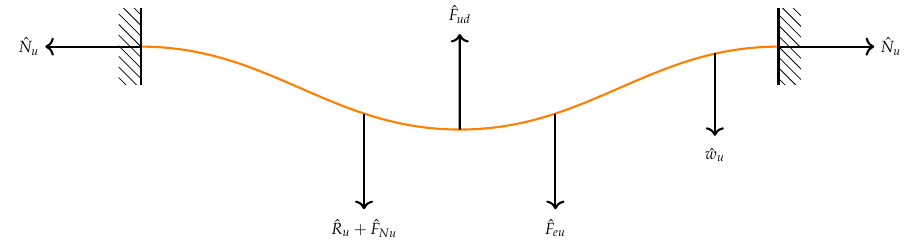
Figure 4. The F.B.D for the upper microbeam under the effect of electrostatic force, damping force, normal force and mid-pane